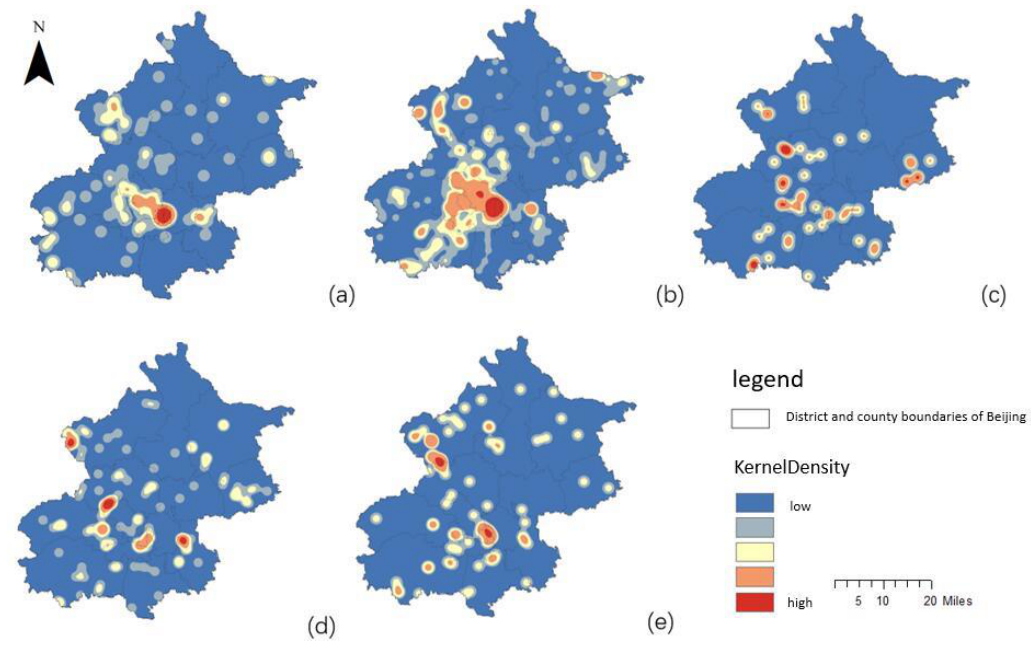
Figure 3 . Kernel density map of different types of cultural preservation units in Beijing.